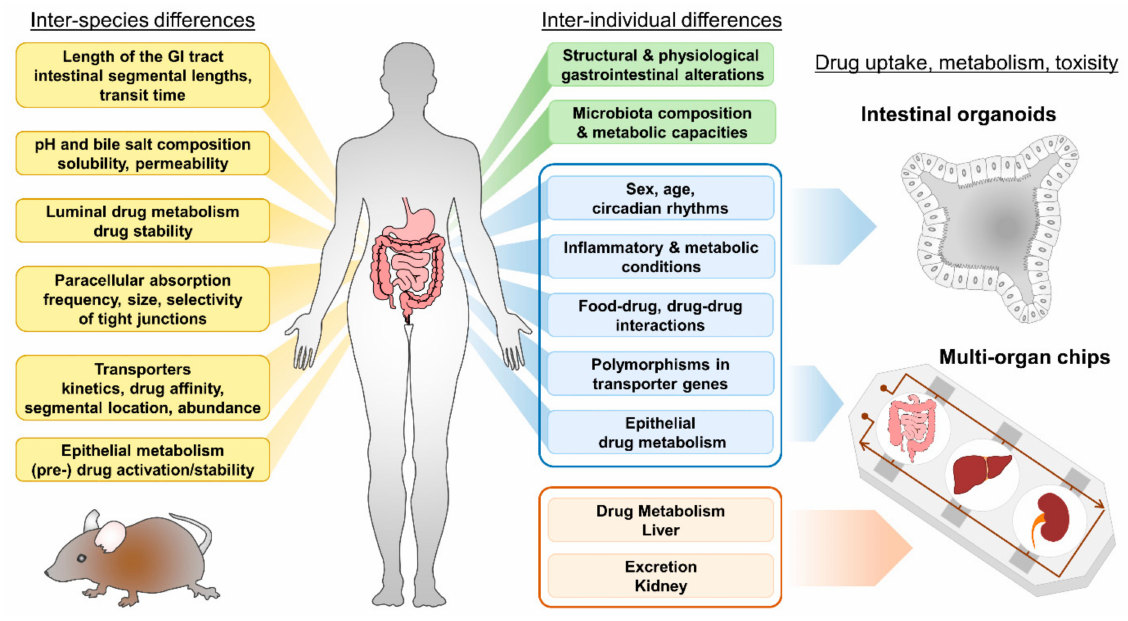
Figure 1. Inter-species and inter-individual differences accounting for differences in oral bioavailability of drugs. Human intestinal organoids and multi-organ chips (MOC) facilitate research including personalized-medicine approaches and drug screening. Aspects given in blue can be modelled by intestinal organoids, systemic (liver) metabolism and excretion (kidney) properties (depicted in light red) can be implemented using